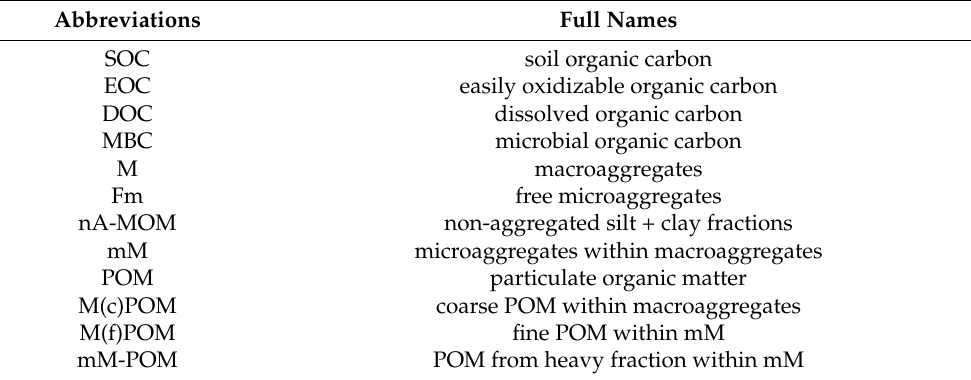
Table 1. The abbreviations and full names of various organic matters and organic carbon fractions, and soil aggregate stability